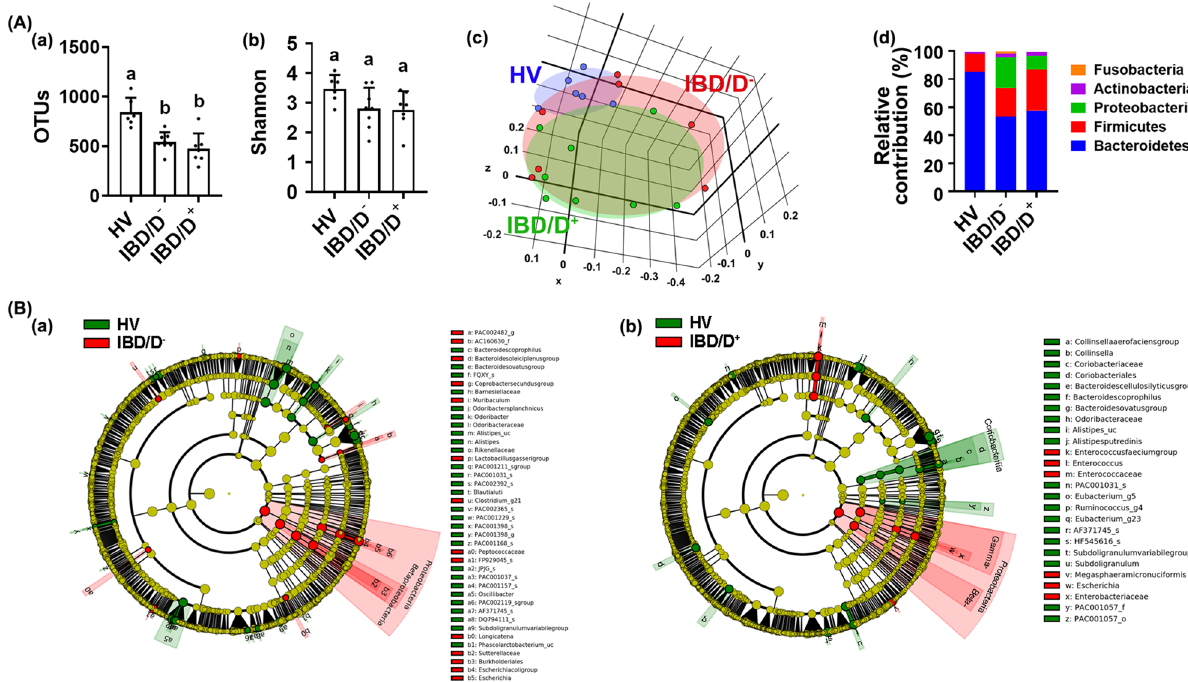
Figure 3. The fecal microbiota composition of patients with IBD/D − or IBD/D + and healthy volunteers (HVs). ( A ) Effects on OTU richness (a), Shannon’s index (b), principal coordinate analysis (PCoA) plot based on Jensen-Shannon analysis (c), and phylum level (d). ( B ) Effects on gut microbiota composition indicated by Cladogram between the feces of HVs and IBD/D − patients (a) and between the feces of HVs and IBD/D + patients (b). The gut microbiota composition was analyzed by using using Illumina iSeq 100. Data values were indicated as mean ± SD (HV n = 6; IBD/D − n = 8; IBD/D + n = 7). Means with same letters are not significantly different ( p < 0.05). (A)(a, b) and (C)(b, c, d), Kruskal–Wallis test (nonparametric test); (C)(a), One-way ANOVA Bonferroni’s multiple comparisons test (parametric test); (C)(e), Mann Whitney test (nonparametric